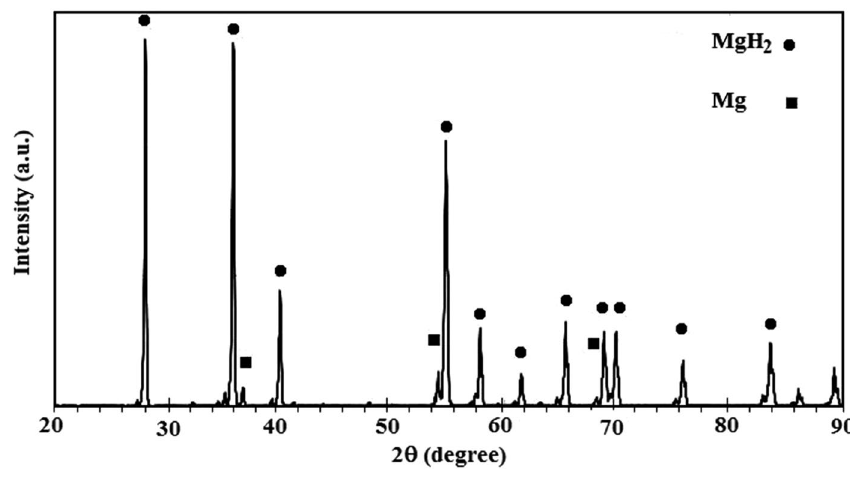
Fig. 2 XRD pattern of the magnesium hydride used in this study